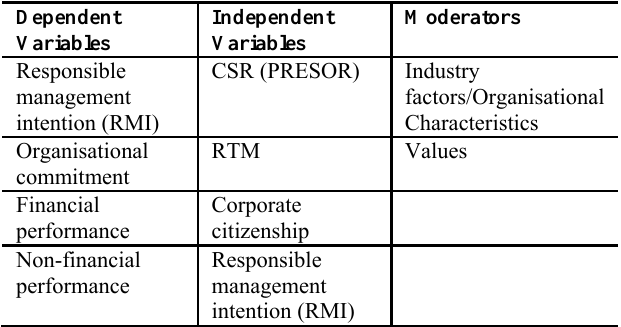
Table 2: Variables of